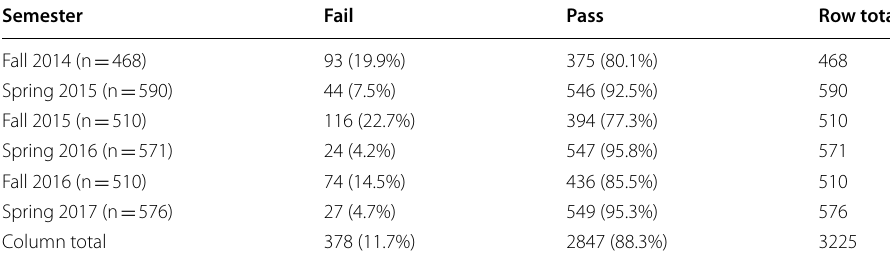
Table 2 Summary grade statistics by